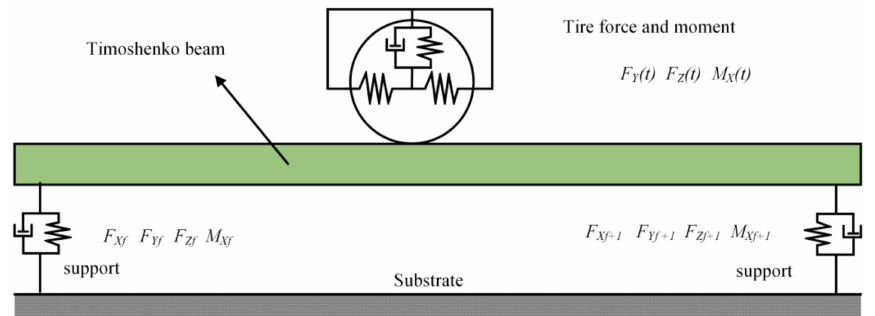
Figure 5. A Timoshenko beam model: kinematic parameters, loadings and coordinate system.